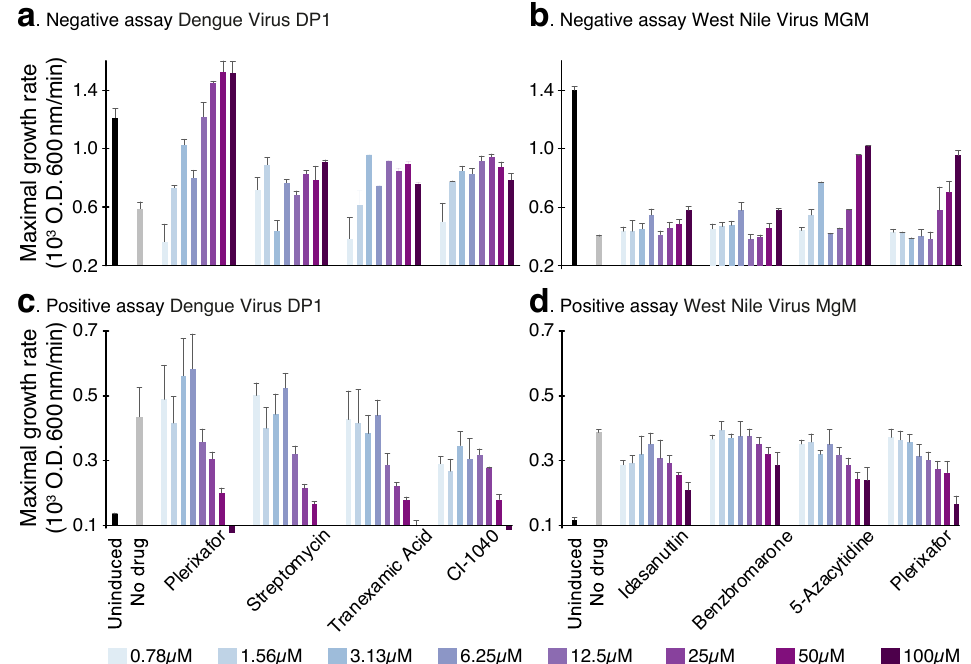
Figure 5. Blocker screening results against Dengue Virus DP1 and West Nile Virus MgM viroporins. Maximal growth rates are depicted as a function of different compound concentrations (0.78–100µM), as noted in the color legend. Bacteria in which the channel expression was not induced or the drug was not added are used as controls. Panels a and b present the negative assay results for Dengue Virus DP1 and West Nile Virus MgM viroporins, respectively. Panels c and d present the positive assay results for Dengue Virus DP1 and West Nile Virus MgM viroporins, respectively.